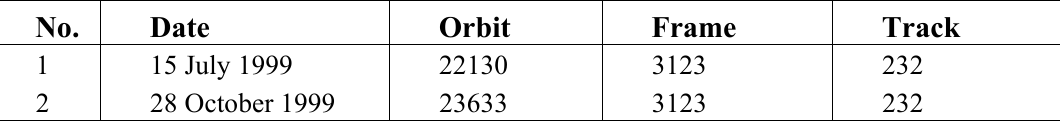
Table 1. ERS-2 SAR data used.